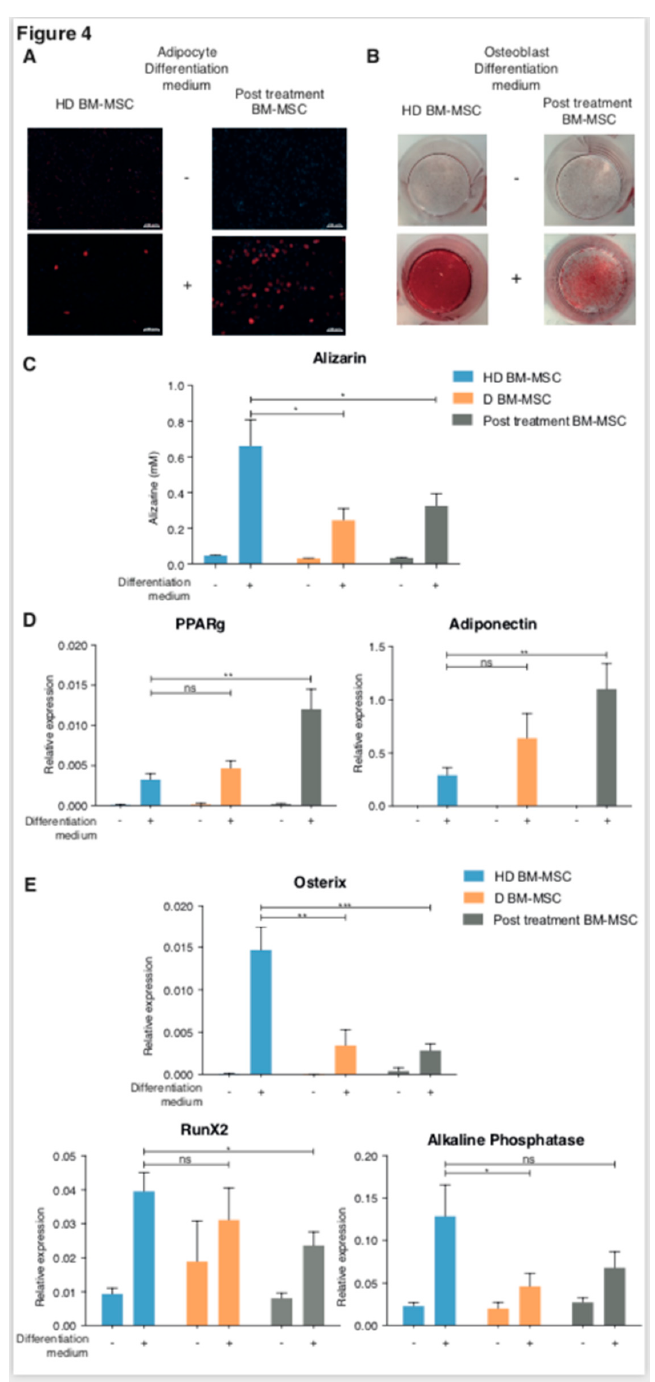
Figure 4. Colorimetric tests in adipocyte or osteoblast differentiation medium ( A – C ) or for 14 days before RT-qPCR analysis. ( D - E ) Colorimetric test was performed with Nile red for adipocyte ( A ) (magnification X5) and alizarin red for osteoblast ( B-C ). Alizarin Red Staining quantification using the assay. Data are expressed as the mean +/- SEM (HD BM-MSC n = 10; D BM-MSC n = 9, post treatment BM-MSC n = 17) with the error bars representing the standard deviations ( C ). RT-PCR of PPARgamma (PPAR γ ) and adiponectin were up regulated after adipocyte differentiation of post-treatment BM-MSC, compared to HD BM-MSC ( D ); and Osterix, Runx2, and Alkaline phosphatase were down regulated after osteoblast differentiation of post-treatment BM-MSC compared to HD BM-MSC ( E ). Data are mean ± SEM of the relative expression from seven independent experiments. * p < 0.05, ** p < 0.01, *** p < 0.001.